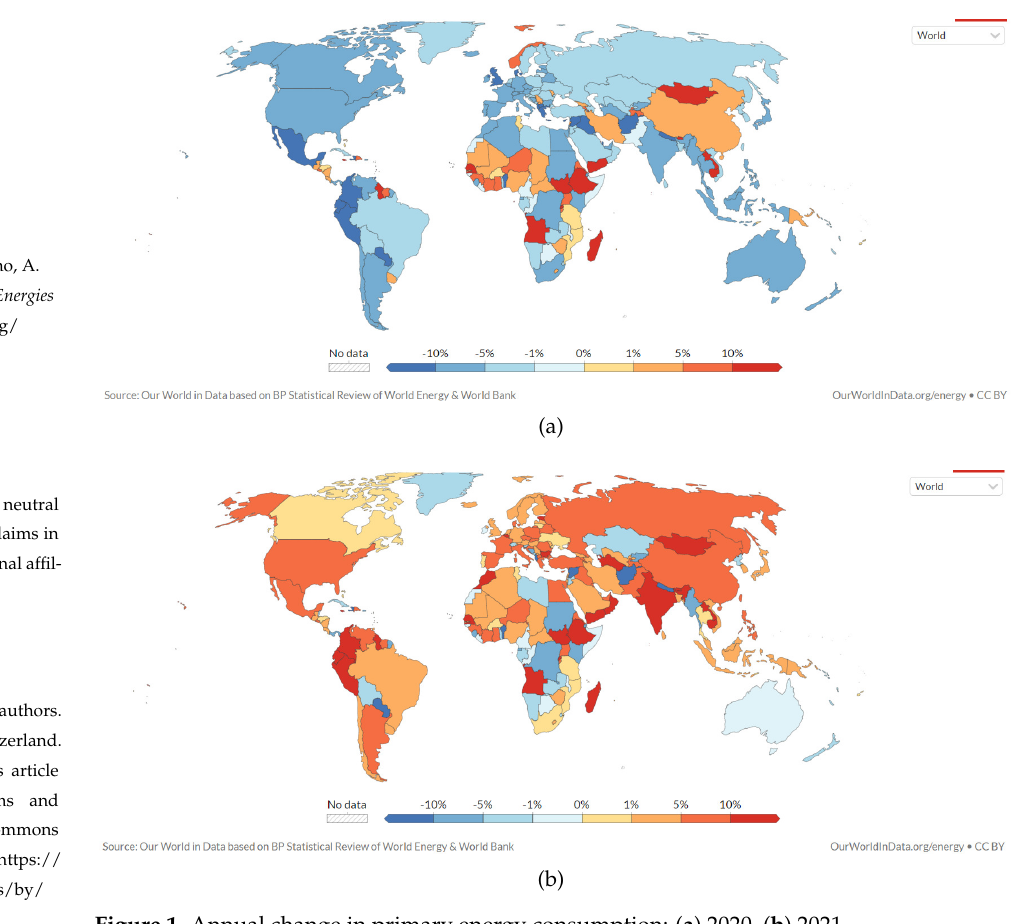
Figure 1. Annual change in primary energy consumption: (a) 2020, (b) 2021.